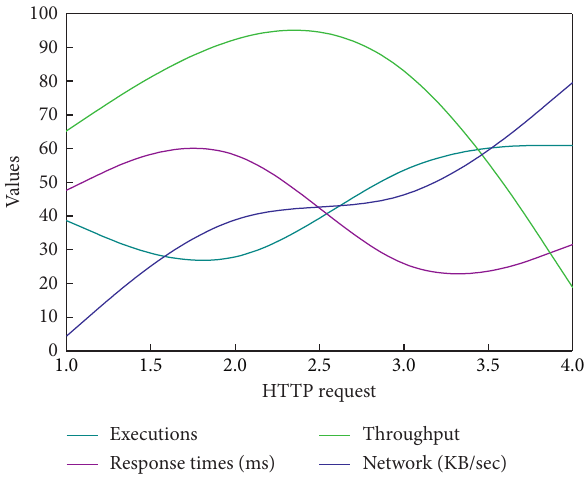
Figure 10: Stress test